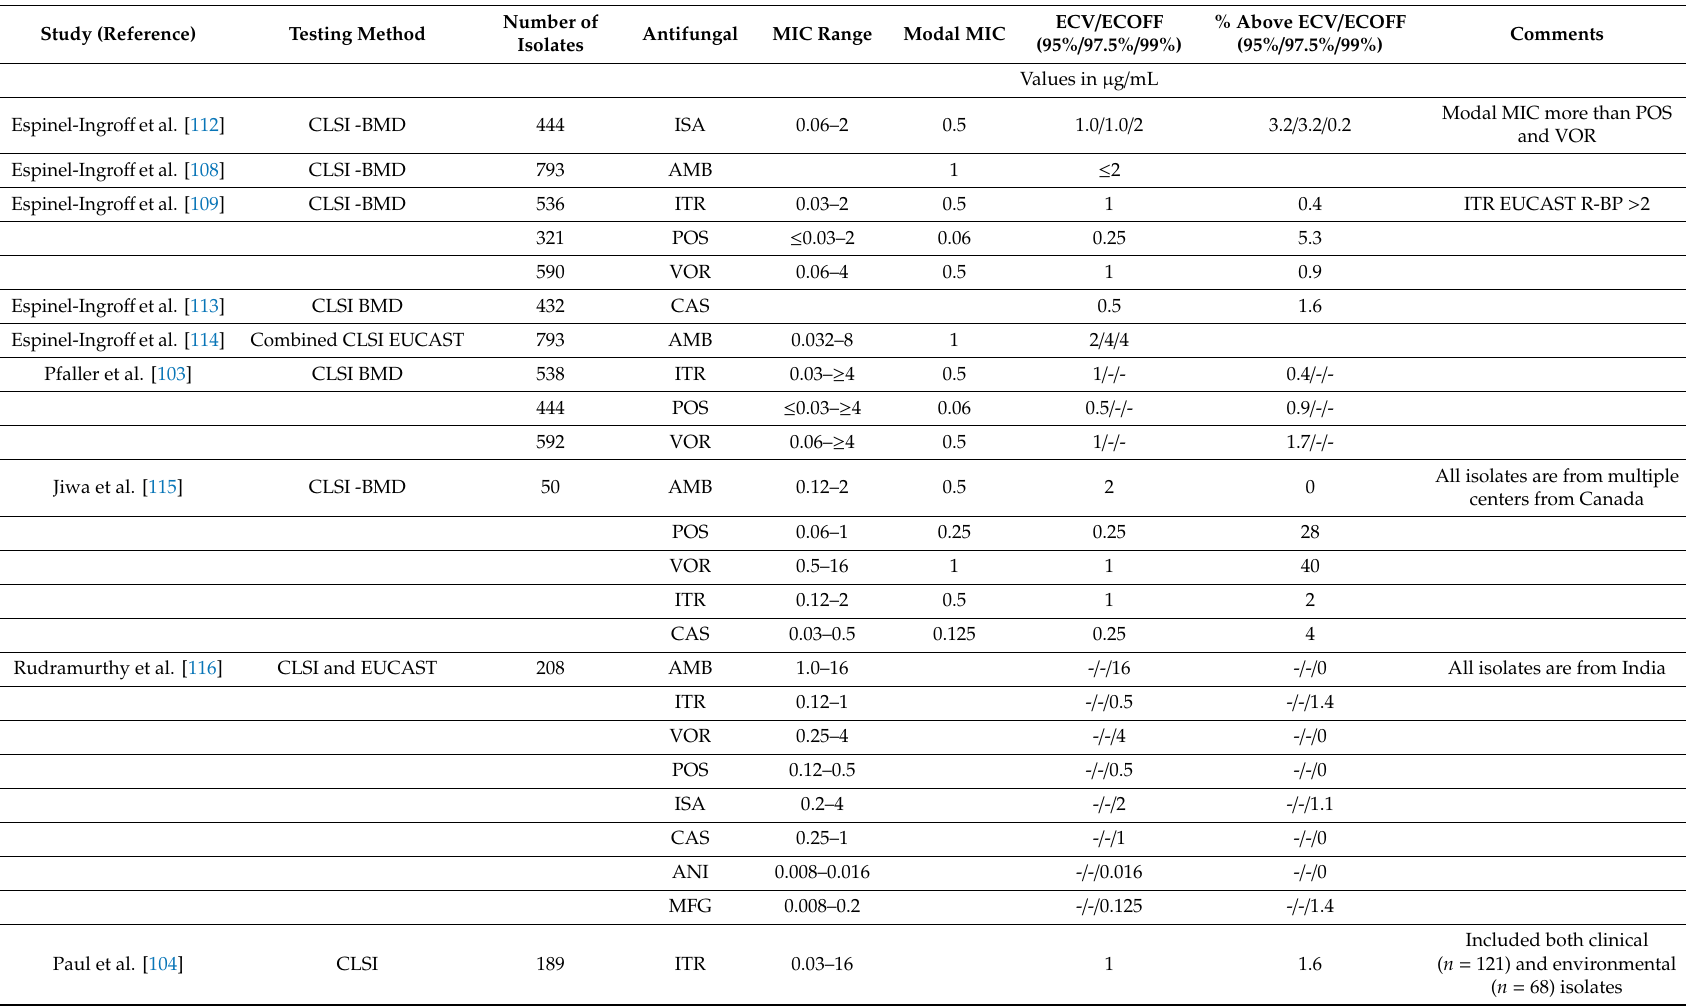
Table 1. Review of Epidemiological Cut-o ff Values (ECVs / ECOFFs) of various antifungal agents against Aspergillus flavus